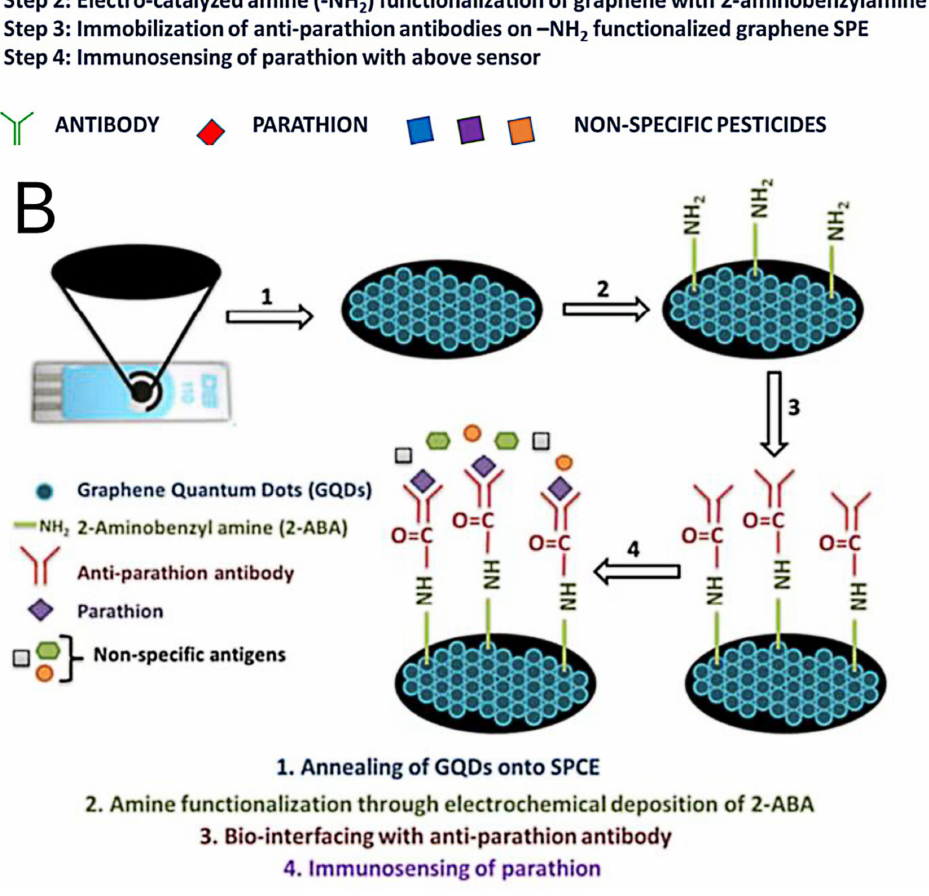
Figure 2. Schematic of the graphene-based, screen-printed immunosensor for parathion ( A ). Re- produced with permission from Mehta et al. [76], Biosens. Bioelectron.; published by 2016 Elsevier B.V. Schematic presentation of the GQDs-modified screen printed immunosensor for parathion ( B ). Reproduced with permission from Mehta et al. [77], Anal. Biochem.; published by 2017 Elsevier Inc.